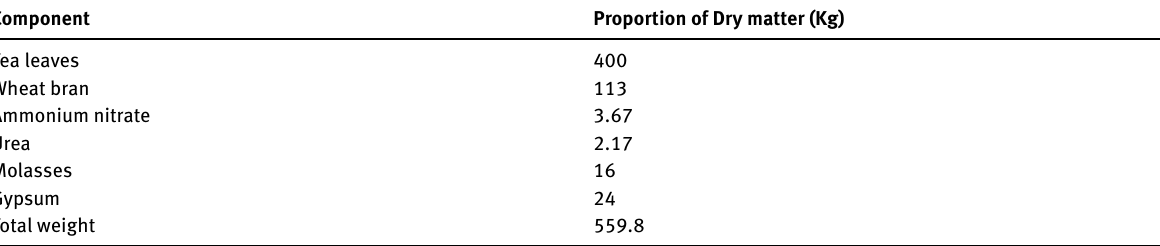
Table 4: Tea leaf compost in Turkey (Simsek et al. 2008) Component